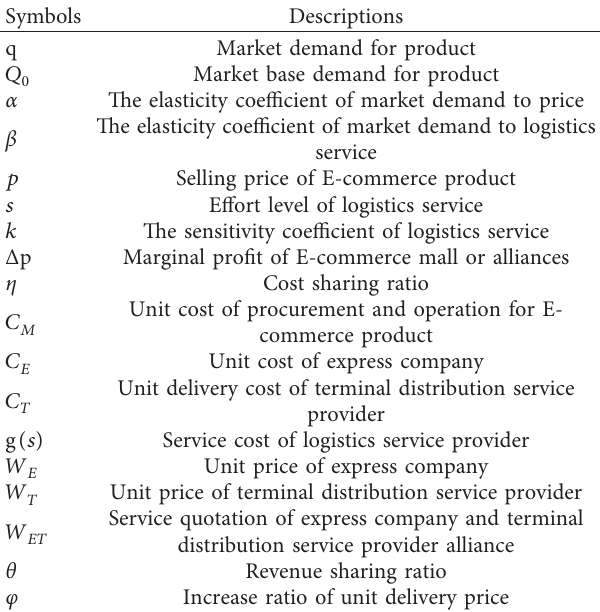
Table 2: Symbols and descriptions of research